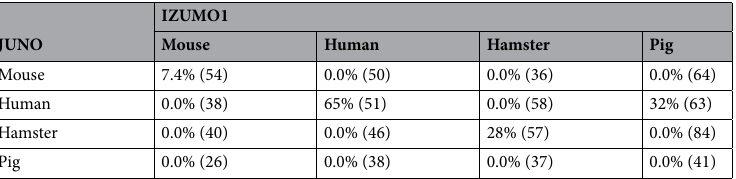
Table 4. JUNO translocation in conspecific and heterospecific cell combinations. Numbers in brackets are the numbers of contacted cell-pairs for each